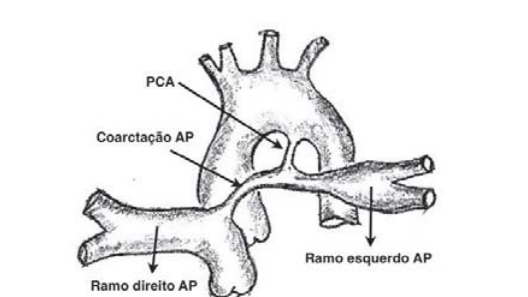
Fig. 1 - Visão anatômica da coarctação da artéria pulmonar e sua relação com o canal arterial patente (PCA). A artéria aorta é vista posteriormente à artéria pulmonar somente para fins de ilustração. Os vasos aórticos e pulmonares são cuidadosamente dissecados, evitando-se a lesão ou espasmo do PCA, que é utilizado para manter a saturação arterial de oxigênio